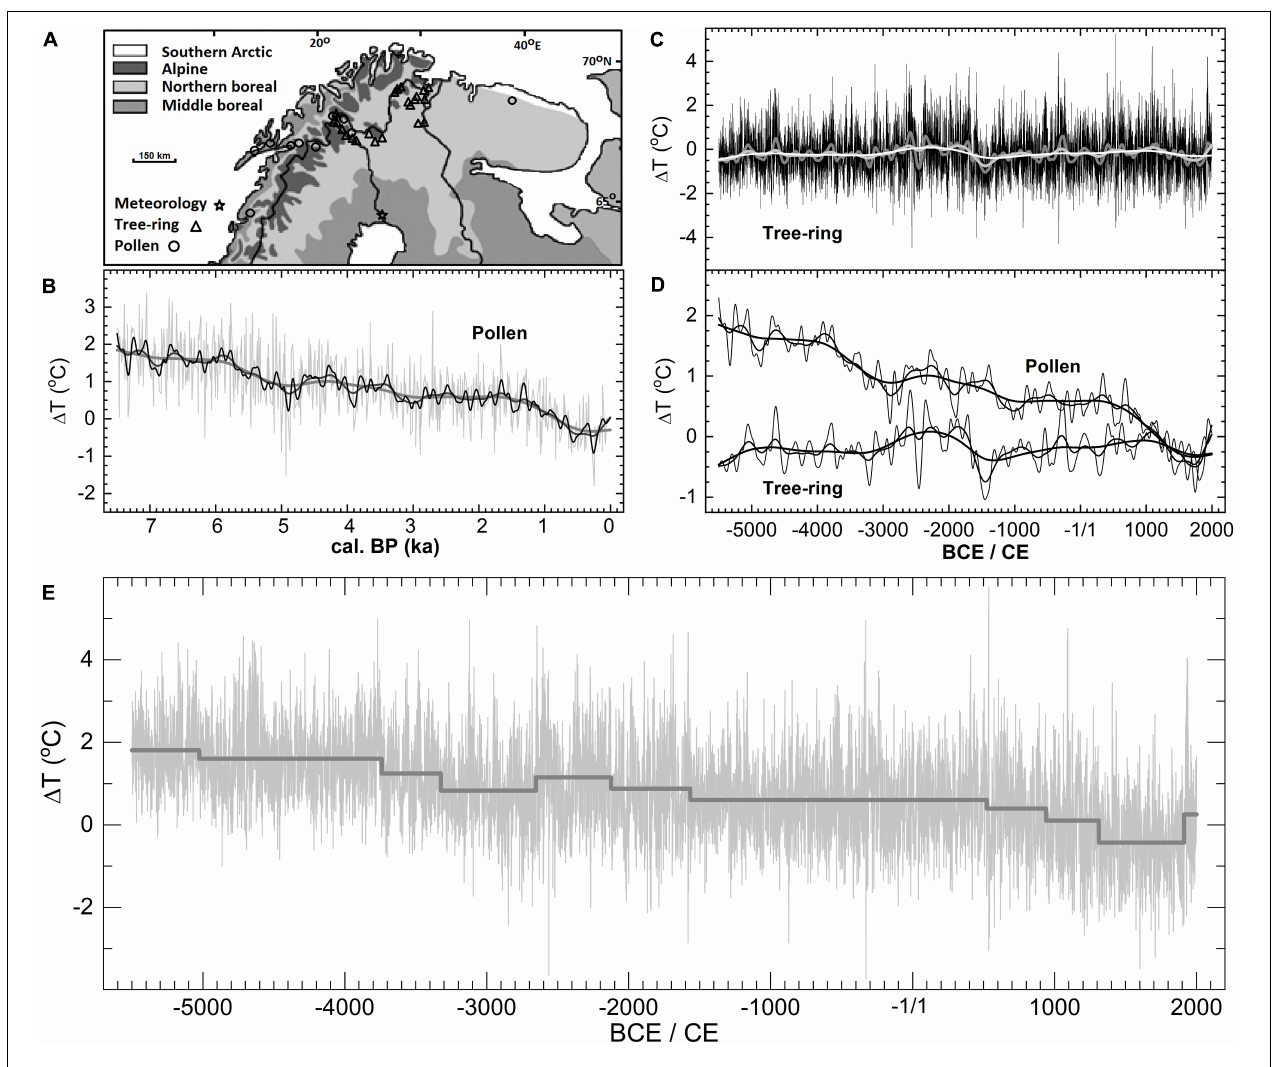
FIGURE 5 | (A) A map of northern Fennoscandia with sites and proxy records used for the proxy-fusions (Helama et al., 2010c, 2012). Locations of the meteorological station and the lakes used for tree-ring studies (one triangle may indicate multiple nearby lakes) and pollen analysis, with approximate major vegetation zones. (B) Reconstructed July temperatures based on the initial data of pollen (C) and tree-ring data, and (D) the low-frequency comparison of pollen and tree-ring proxy records, shown as raw values and as filtered to exhibit the timescales of centennial, multi-centennial, and millennial components of the variability. (E) Annually resolved July temperature estimates produced by the proxy-fusion (Helama et al., 2012) shown with the temperature regimes and shifts in the reconstructed values. All temperature records ( (cid:49) T) are shown relative to the reference period AD